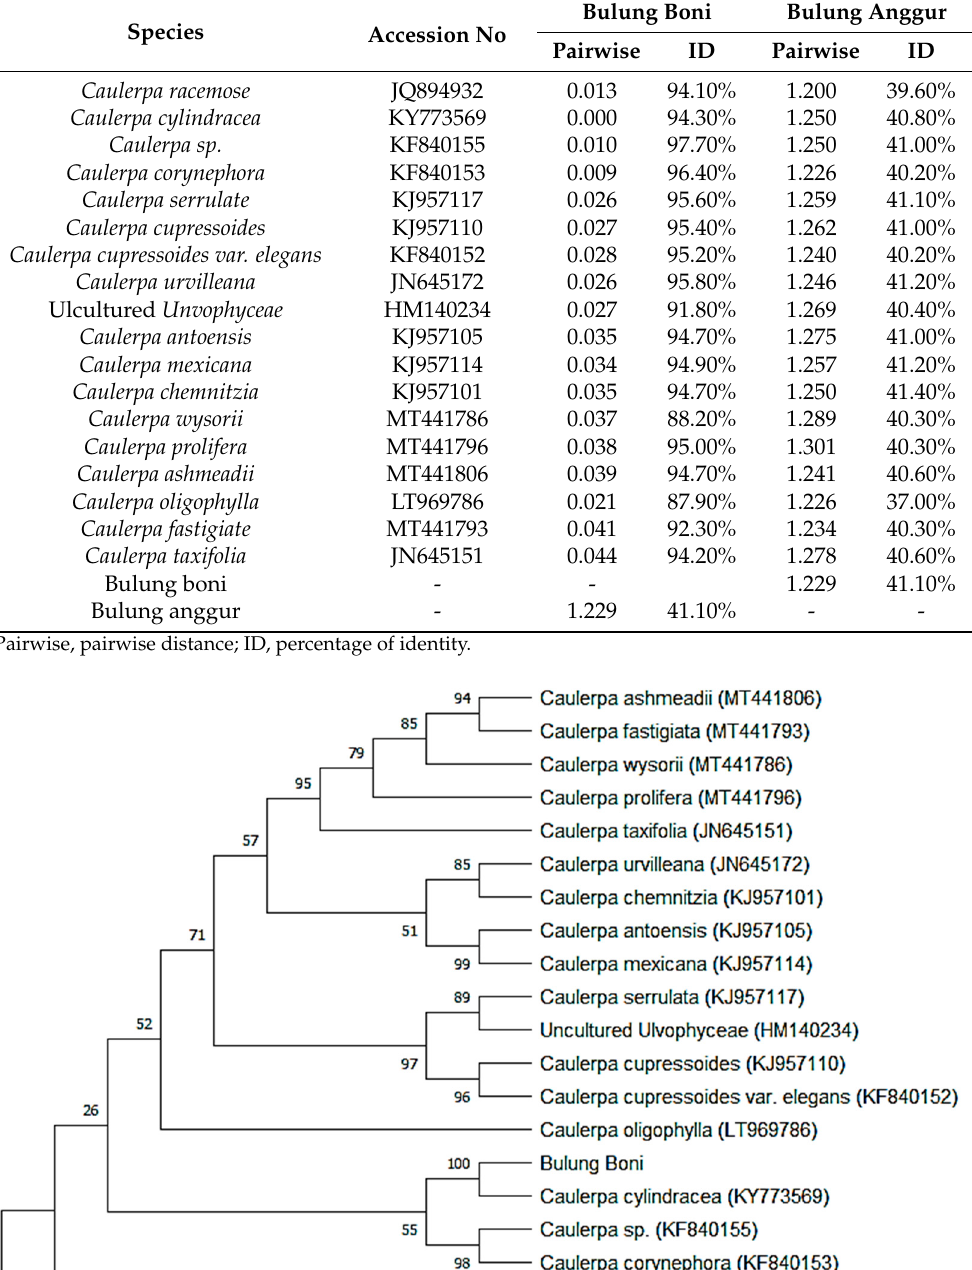
Table 3. Barcode alignment for Bulung Boni and Bulung Anggur collected from Bali. The best matched identify with NCBI-BLAST are noted with their GenBank accession number, pairwise distance, and similarity percentage (ID).